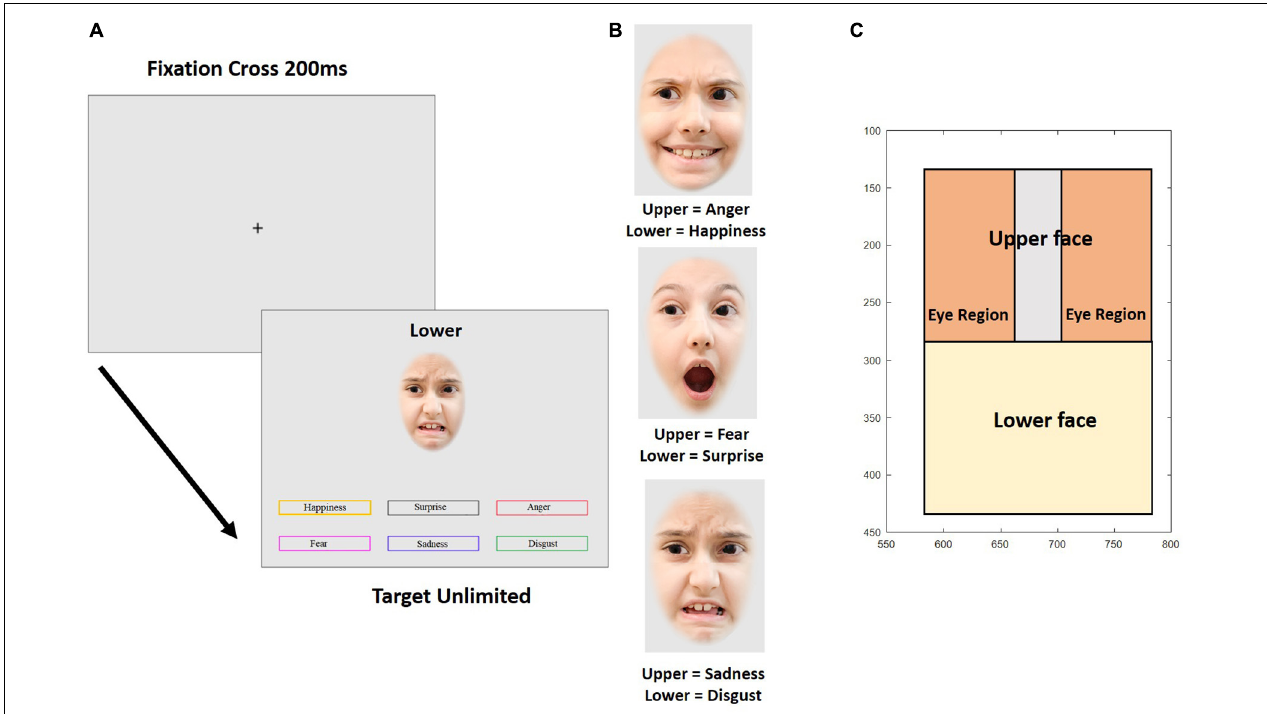
FIGURE 5 | Experiment 2. (A) Temporal sequence of a trial in the emotion composite task. Example trial with the target emotion “disgust” at the bottom half of the face. (B) Examples of emotional composite faces. (C) Parameterization of the variables for gaze behavior. The axes show pixels coordinates on the screen. The pictures are for illustration only and were neither taken from the CAFE database nor used in the experiment.